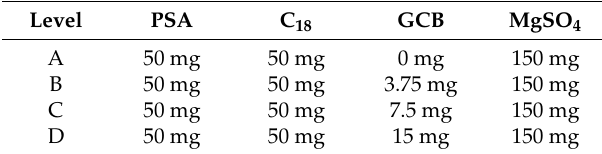
Table 2. Four levels of the composition for dispersive solid-phase extraction (dSPE) clean-up. Level PSA C 18 GCB MgSO 4 A 50 mg